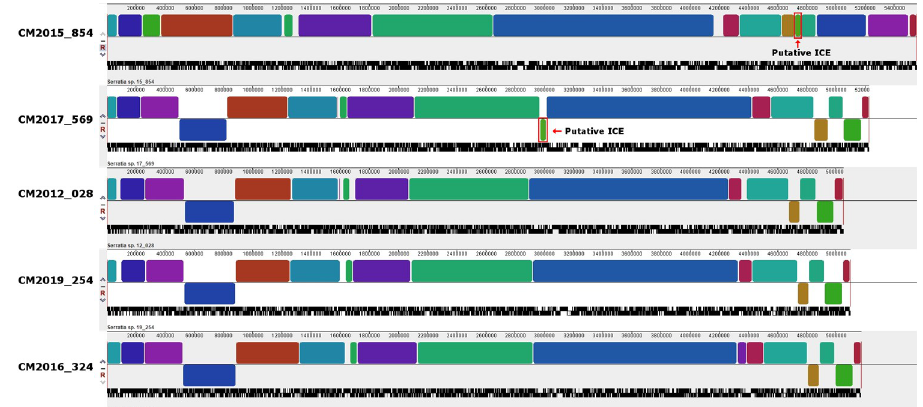
Fig 6. Progressive Mauve alignment of the chromosomes from representative U-vet Serratia isolates, showing the presence of an Integrative Conjugative Element in two chlorhexidine-tolerant strains. The position of the predicted ICE region in CM2015_854 and CM2017_569 is indicated by the red box. Locally colinear blocks are indicated in solid